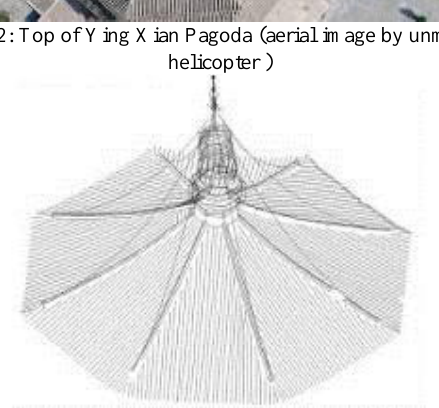
Figure3: 3D model in CAD software